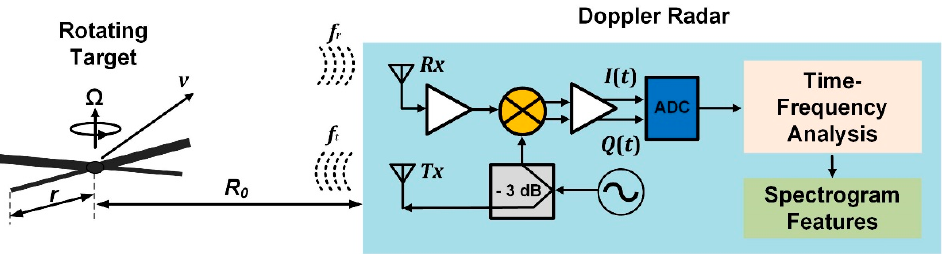
Figure 1. Block diagram for structural health monitoring (SHM) based on low-cost Doppler radars using time-frequency analysis of micro-Doppler signatures.